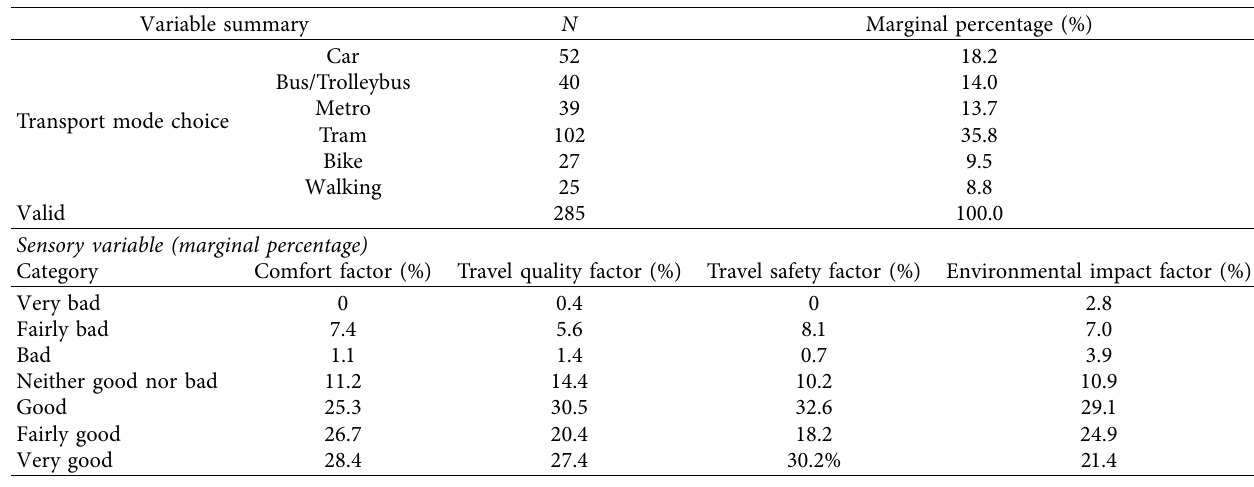
Table 3: The description of the analysis to the proportion of the